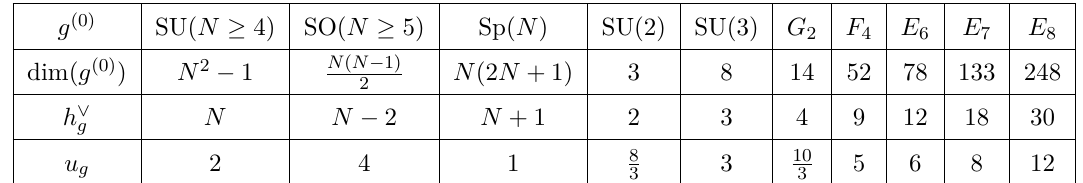
Table 2 . Dimension dim ( g (0) ) , dual Coxeter number h ∨ compact simple gauge groups g (0) . The groups SU(2) and SU(3) require special treatment because they do not have quartic